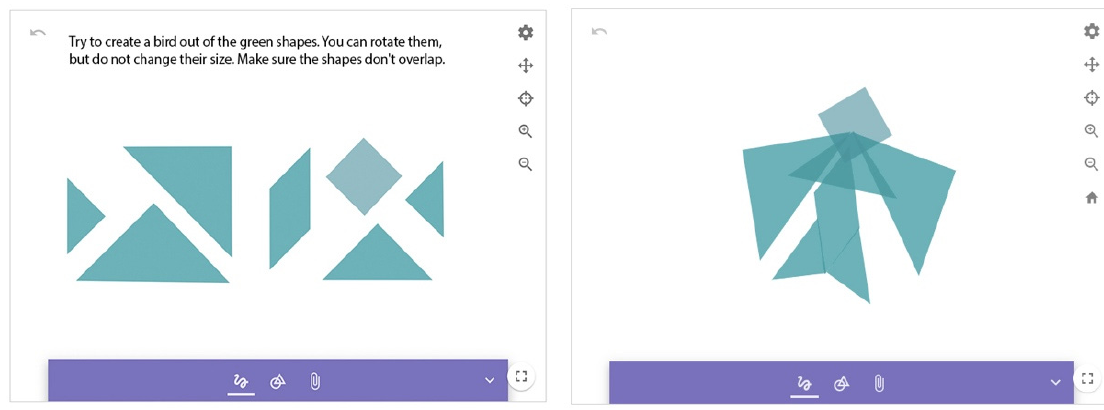
Figure 4. Figurative composition 2.